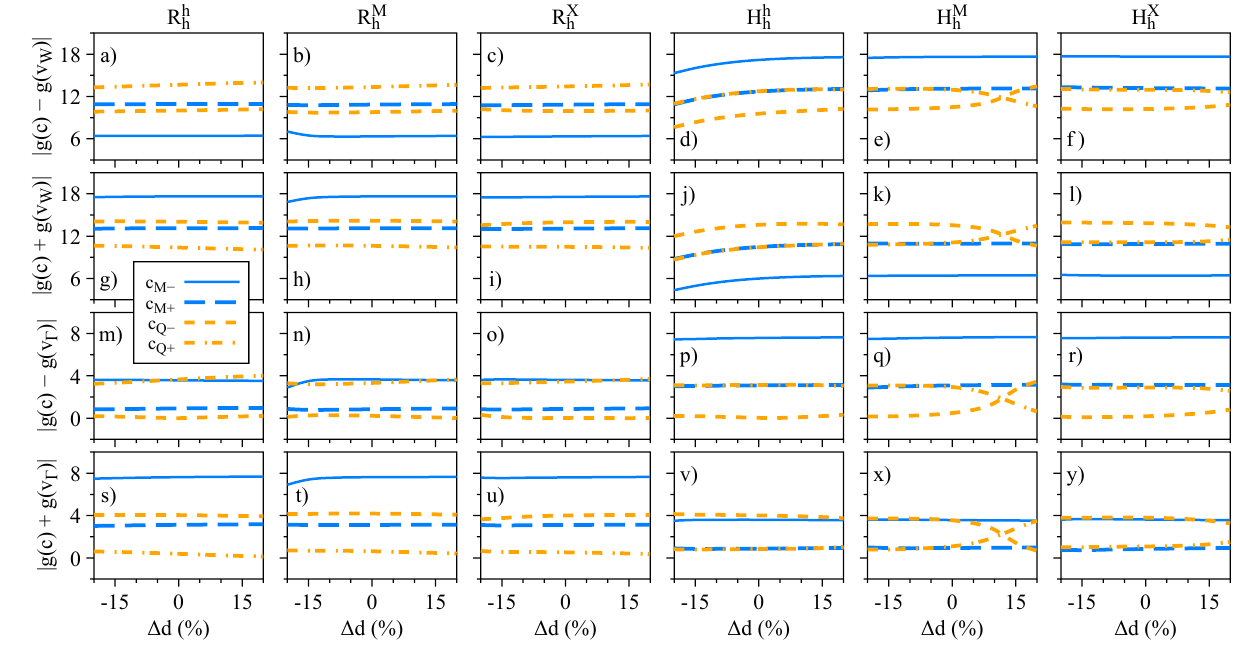
Figure 16. Same as Figure 14 but as a function of the interlayer